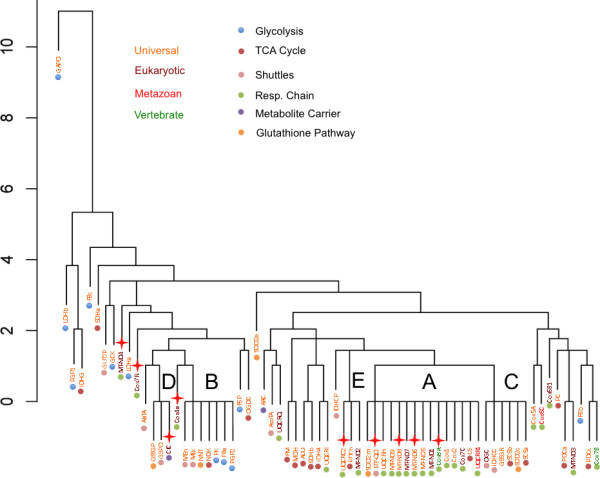
Similarity of gene duplication histories in the GSIS system. The cluster diagram is constructed from Euclidian distances between vectors of gene duplication history as described in the Materials and Methods. Gene names are coloured according to their phylogenetic classification (red = Metazoan, orange = Universal, brown = Eukaryotic, green = Vertebrate). Coloured dots represent pathway membership as shown in the key. Red stars indicate genes inferred to have undergone at least one episode of positive selection, according to the Selectome database (see Table 2 for more detail).